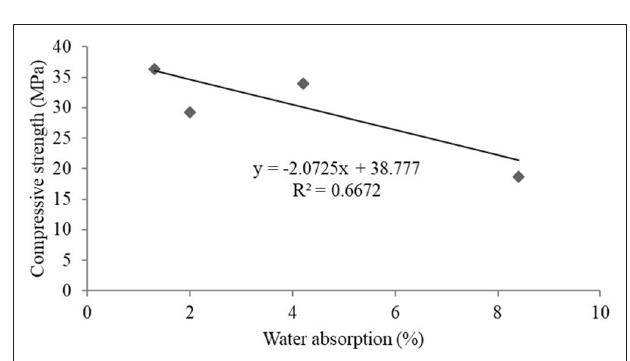
FIGURE 2 | Relationship between compressive strength and water absorption.